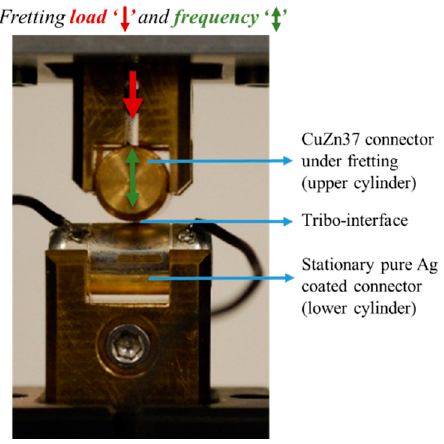
Figure 2. Test rig set-up to simulate the fretting phenomenon.